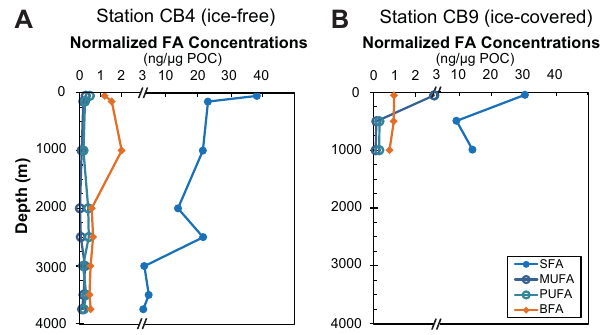
Fig. 4. δ 13 C values of individual fatty acids with depth where SFAs are in blue shades, BFAs are in orange shades and open circles rep- resent MUFAs and PUFAs for (a) Station CB4 and (b) Station CB9. POC and DOC (Griffith et al., 2012) are represented by black